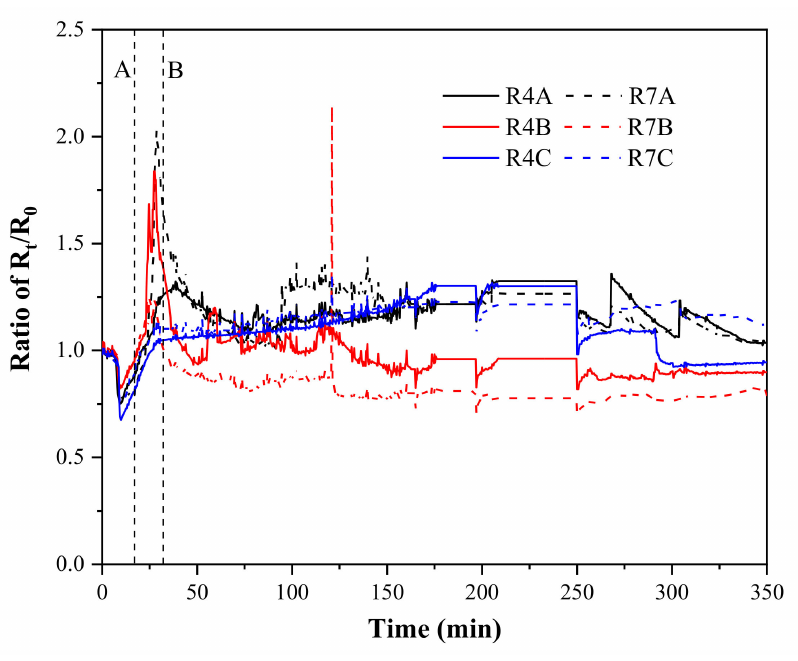
Figure 13. Evolution of R t /R 0 ratios for R4 and R7 from the boundary to the center and different horizons of the hydrate-bearing sediment during the whole gas production